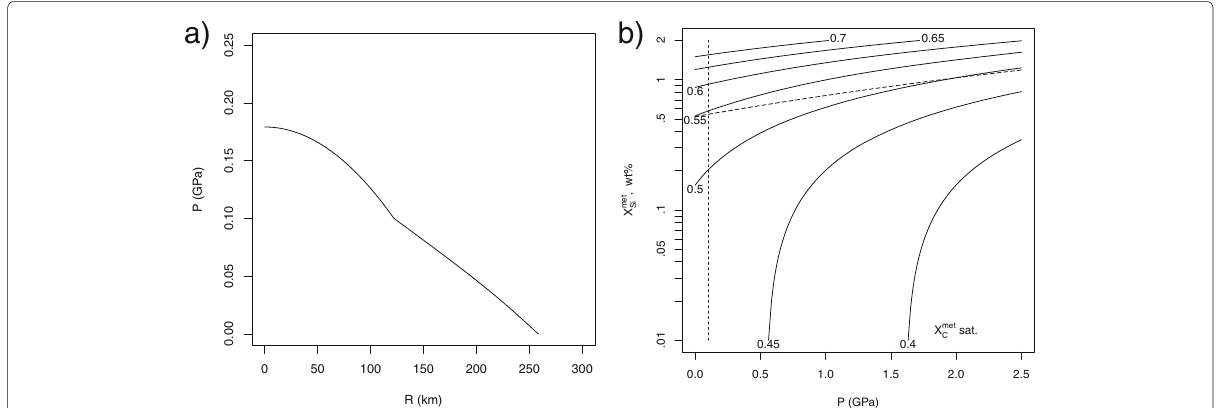
Fig. 1 a Internal pressure within Vesta, using geodetic data from Russell et al. (2012) and methods from Helffrich (2017). Core-mantle boundary (CMB) pressure is evident in knickpoint in P ( R ) curve. b Sulfur model applied to Vesta, using average estimates of bulk Vesta composition. Contours show wt% S in Vesta silicate assuming metal-silicate equilibrium at indicated pressure ( P ) and sulfur content of silicate X sil Vestan CMB pressure from a . Sloped horizontal line is X met pressures at or below the Vestan CMB (lower left), silicate sulfur content is 0.47 ≤ X sil (Kitts and Lodders 1998)